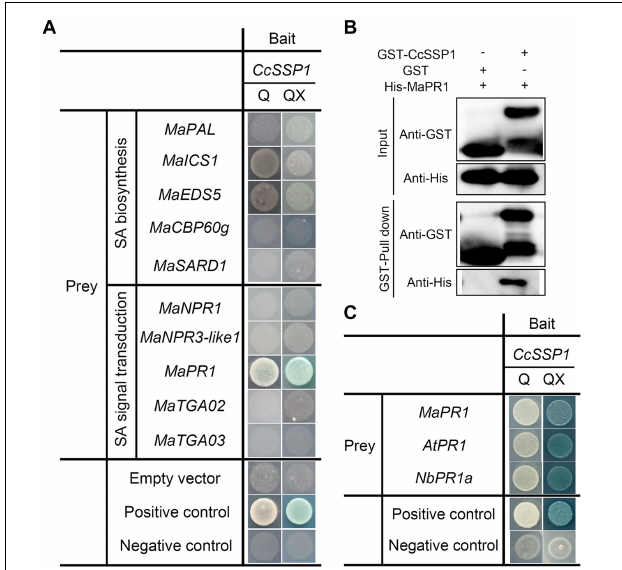
FIGURE 6 | CcSSP1 interacts with MaPR1. (A) Y2H analysis of the interaction between CcSSP1 and key genes from the SA signaling pathway. pGBKT7-p53 was mated with pGADT7-T as a positive control, and pGBKT7-Lam was mated with pGADT7-T as a negative control. Q, SD/-His/-Leu/-Trp/-Ade (quadruple dropout medium); QX, SD/-His/-Leu/-Trp/-Ade + X- α -Gal + 200 ng/ml AbA + 10 mM 3-AT. AbA, Aureobasidin A; 3-AT, 3-amino-1,2,4-triazole. (B) In vitro pull-down assays of CcSSP1 with MaPR1. GST-tagged CcSSP1 and His-tagged MaPR1 were expressed in Escherichia coli . Coprecipitation of His-MaPR1 with GST-CcSSP1 was visualized by Western blot before (input) and after affinity purification (pulldown) using glutathione magbeads. (C) CcSSP1 and PR1 homologs interact in yeast. AtPR1, PR1 in Arabidopsis thaliana ; NbPR1a, PR1 in Nicotiana benthamiana